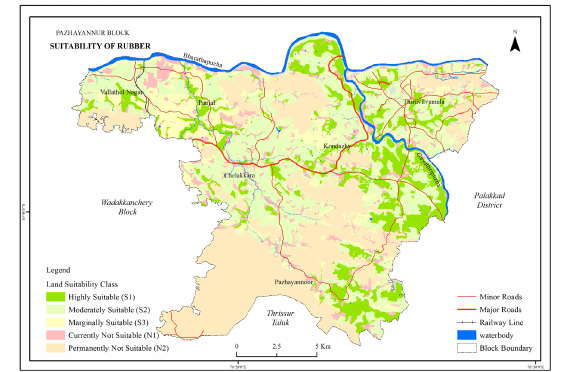
Figure 4. Land Suitability for Rubber Cultivation